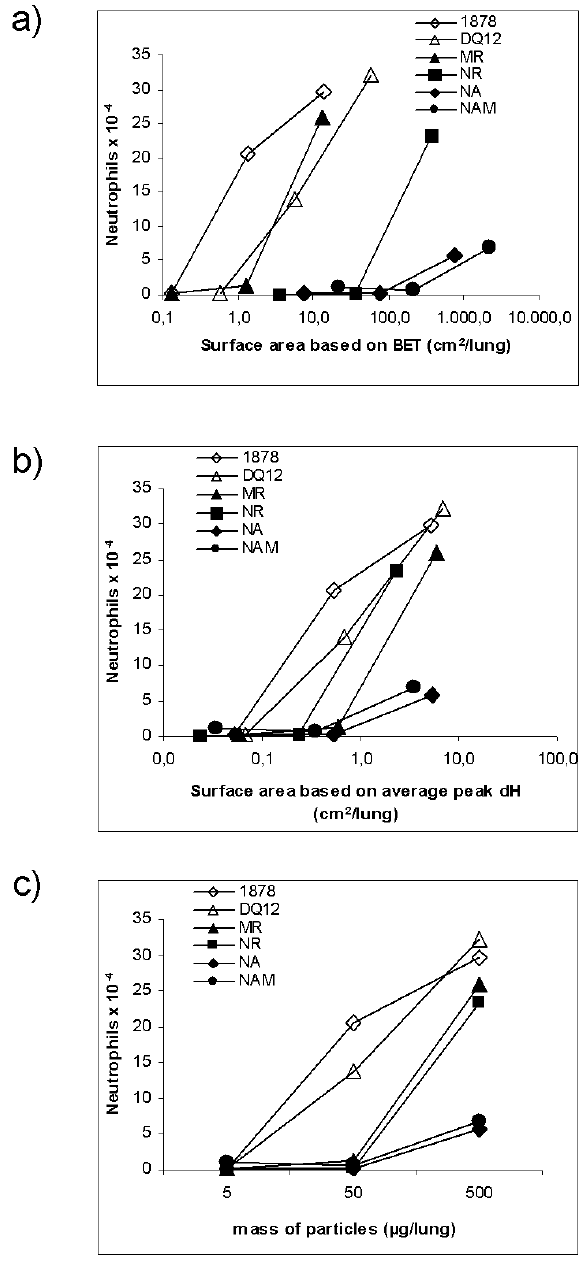
FIGURE 10. Surface area and mass vs. acute neutrophil inflammation. The surface area and the mass instilled for each type of particle were plotted against neutrophil counts 24 h postexposure. (a) The particle surface areas instilled were calculated from the BET size and (b) from the hydrodynamic diameter (dH). (c) The mass of instilled particles was also used as